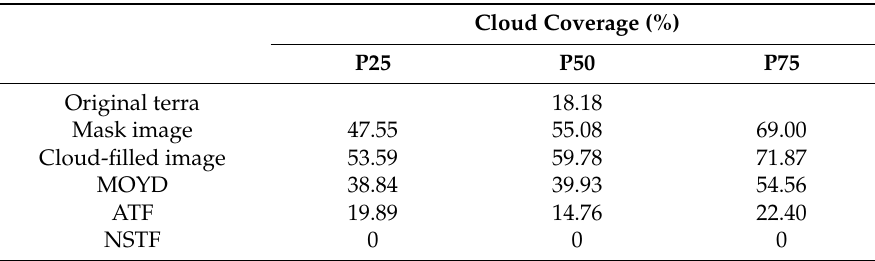
Figure 8. Cloud coverage of the original MODIS SCF images after the execution of each gap-filling step. The results from four days (1 January 2001, 1 January 2005, 1 January 2009, and 1 January 2013) are displayed from top to bottom. The columns, from left to right, represent MOD, MYD, and the three consecutive applications of MOYD, ATF and NSTF, respectively. Table 3. The cloud coverage of selected “cloud-free” MODIS SCF images, three extracted mask images, three artificially cloud-filled images, and after the execution of each gap-filling step for the one-day cloud mask.